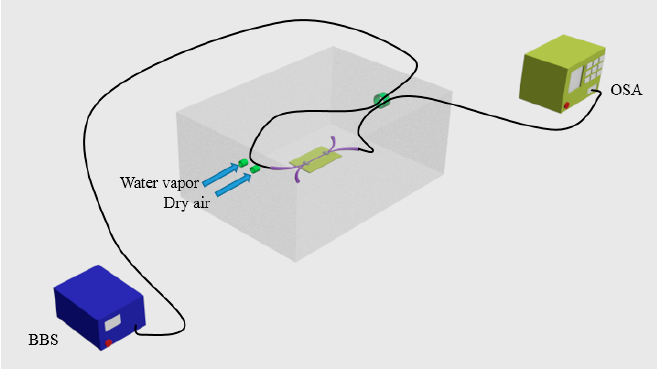
Figure 25. Schematic diagram of experimental setup for humidity sensing of MFC based humidity sensor.